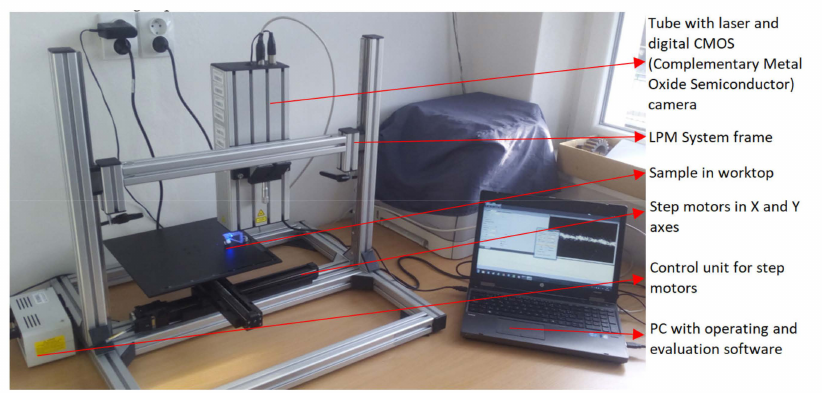
Figure 4. The laser profilometer